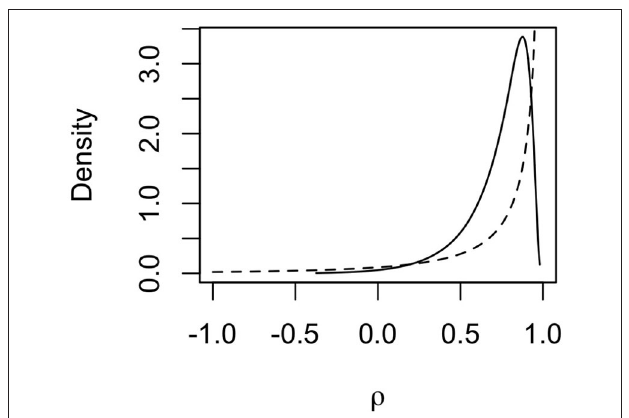
FIGURE 6 | Prior (dashed line) and posterior (solid line) distribution for the autocorrelation parameter ρ for mitochondrial haplotype effects on milk yield in cattle.